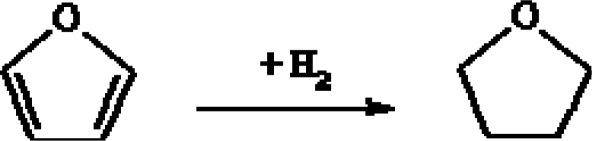
Furan hydrogenation to form C4H8O.